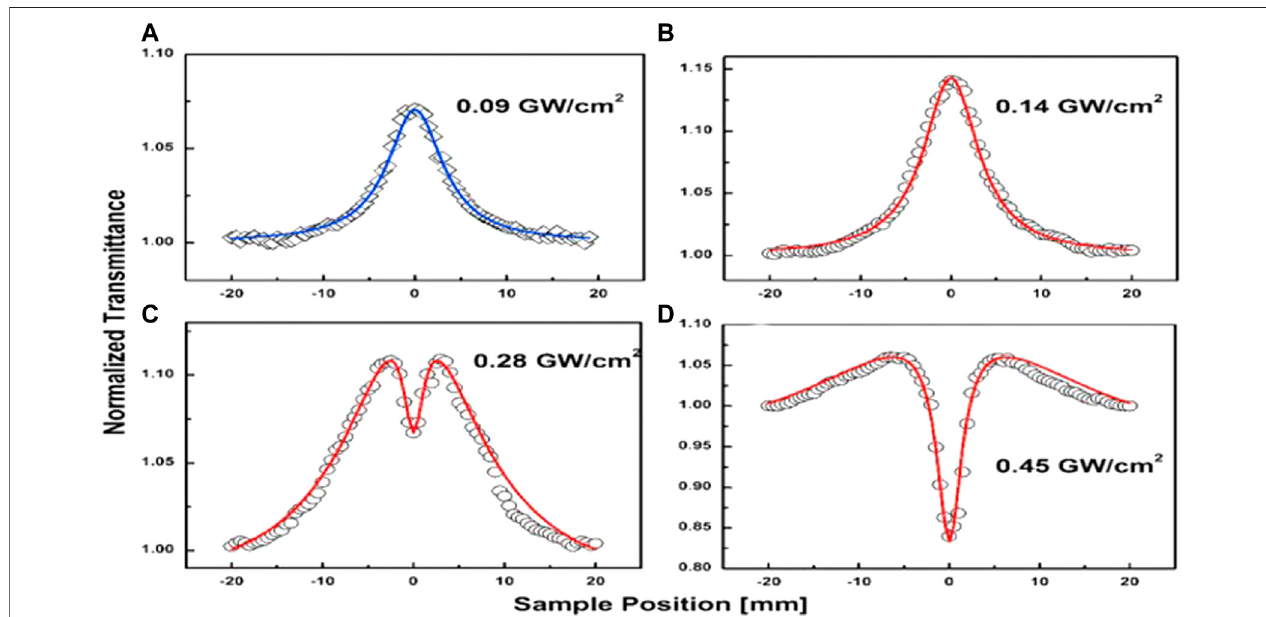
FIGURE 12 | CdSe QDs intensity-dependent nonlinear absorption curves at various input intensities with 532 nm, ns laser pulse [135].